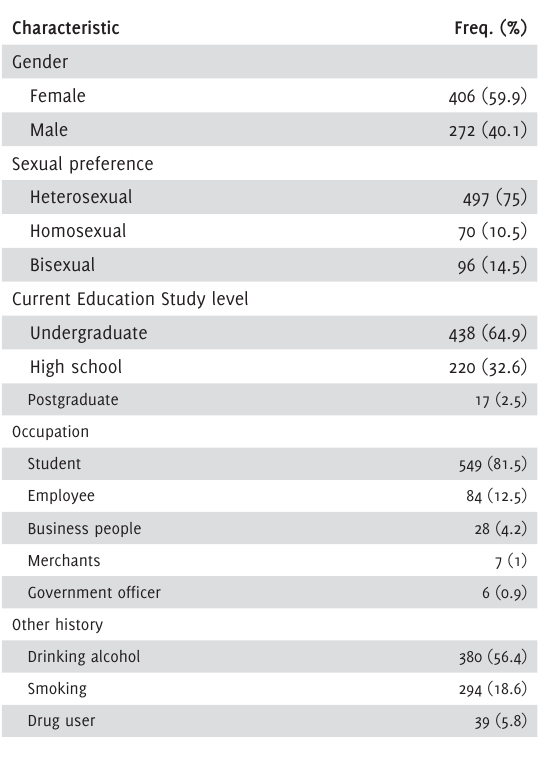
Figure 1. Condoms Packaging Designs